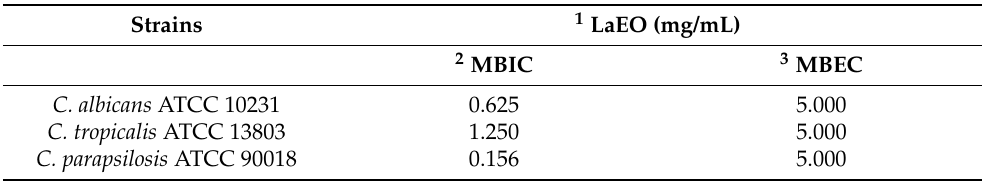
Table 5. MBIC and MBEC of LaEO for Candida